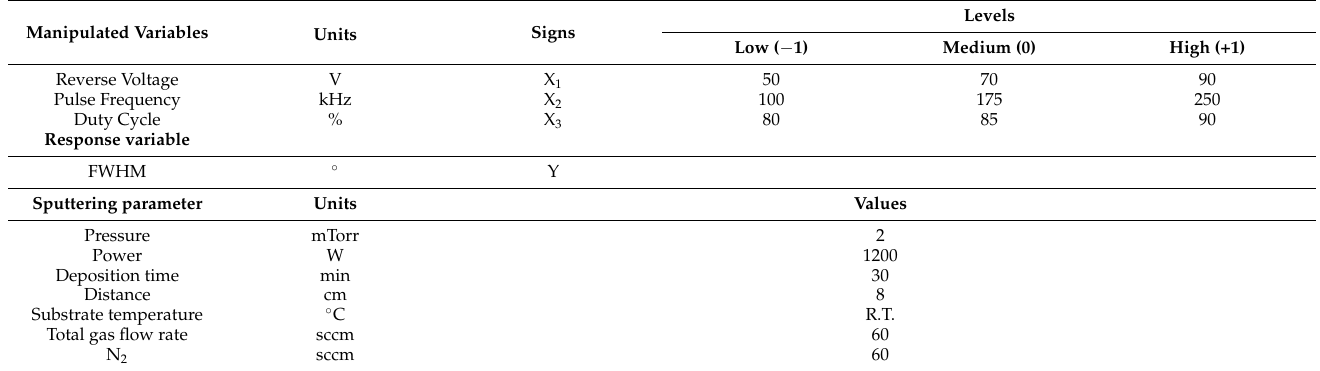
Figure 2. The schematic diagram of the sputter chamber. Table 1. The interaction variables of the factor levels and sputtering conditions by experimental design.